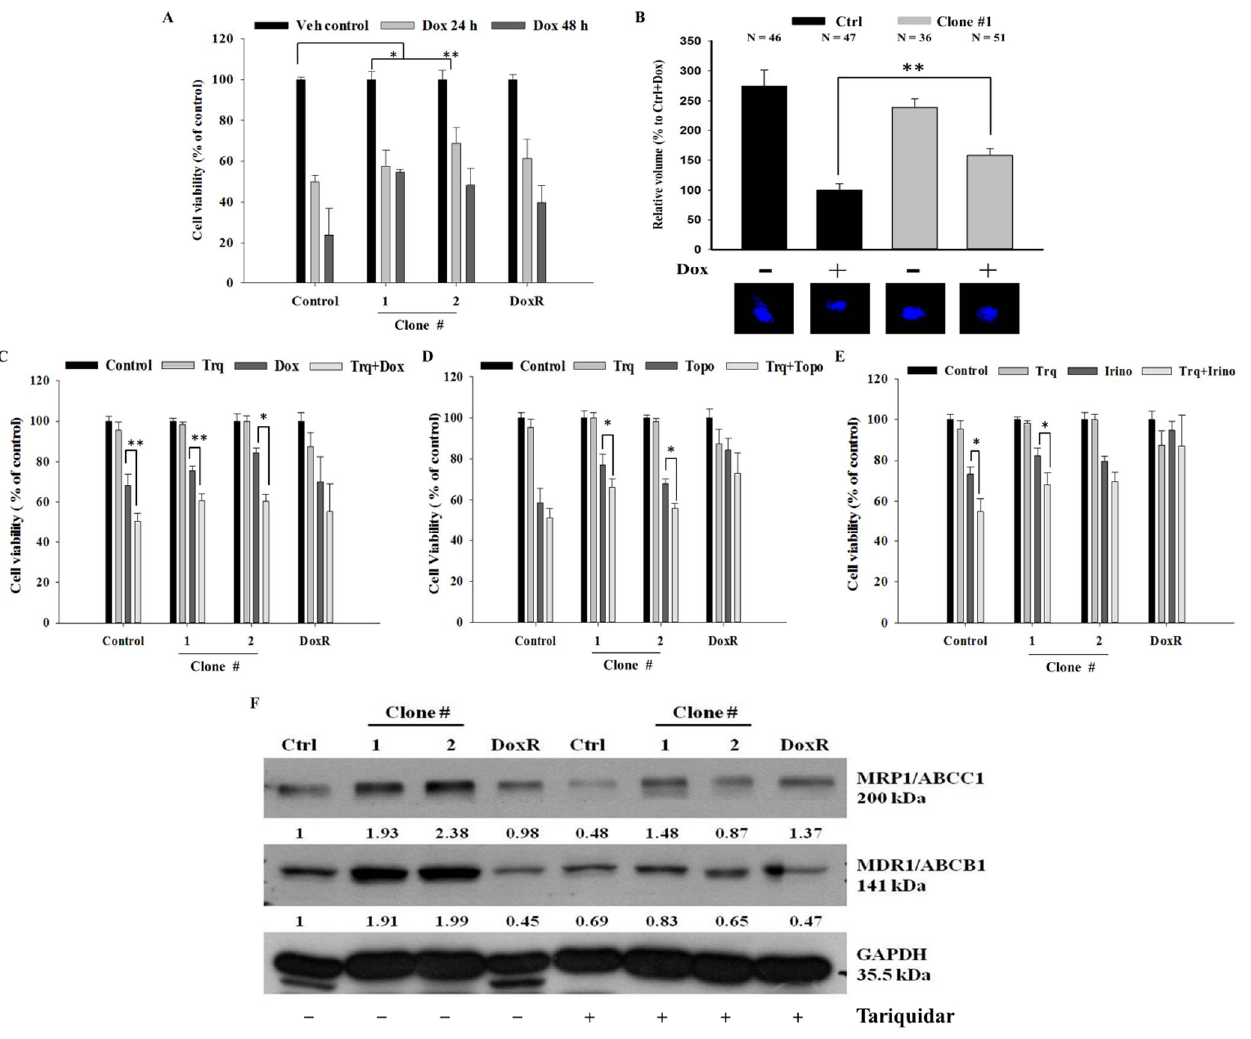
Figure 4. Quantitative analysis of cell viability by Trypan blue cell viability assay. ( A ) Control, DoxR and DEHP-exposed MDA-MB-231 cells (clone #1 & #2) treated with Dox (1 µ M) for 24 or 48 h show induced drug resistance. ( B ) Representative and quantitative results of in vivo zebrafish xenograft assay; DEHP induced Dox resistance and increased proliferation is observed in MDA-MB-231 cells injected in 48 hpf zebrafish embryo challenged with Dox (25 µ M) for 48 h (N = number of embryos/treatment). ( C – E ) Induced cell viability observed in DEHP-exposed clones challenged with Dox (1 µ M), topotecan (1 µ M), and irinotecan (1 µ M) for 24 h; 2-hour tariquidar (P-gp inhibitor) pretreatment enhanced the drug cytotoxicity of Dox, topotecan, and irinotecan, reversing the acquired drug resistance in long-term DEHP-exposed clones and parental MDA-MB-231 cells. ( F ) Western blotting results show the specific inhibition of both MRP1/ABCC1 and MDR1/ABCB1 after tariquidar treatment for 72 h in both control and DEHP-exposed MDA-MB-231 clones (#1 and #2). * p < 0.05, ** p < 0.001.